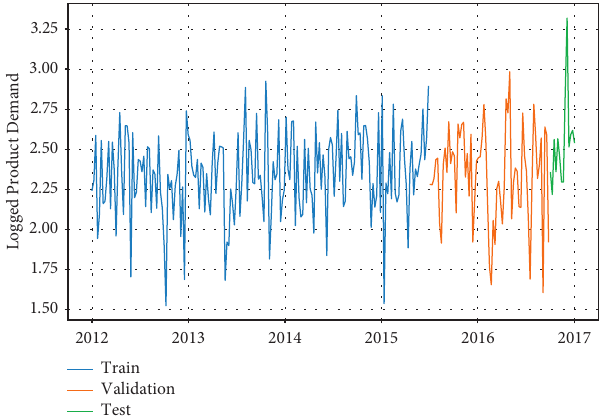
Figure 8: Segmented line graph showing various datasets.